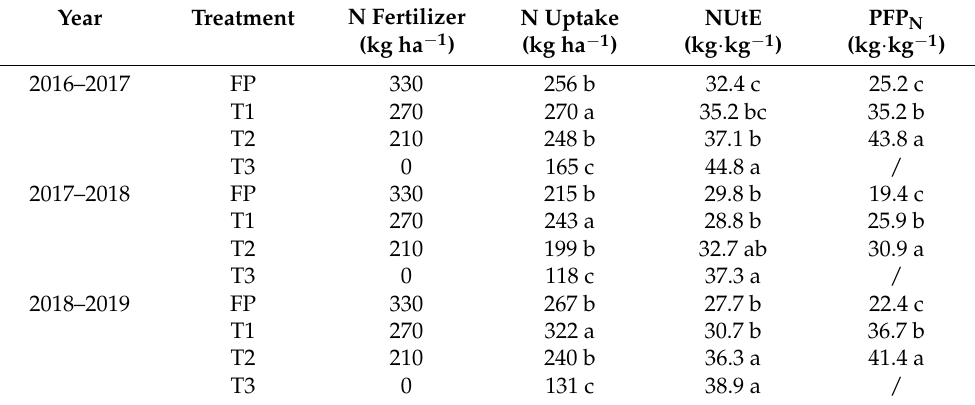
Table 6. Annual chemical N fertilizer input, total N uptake by the plant, N use efficiency (NUtE), and partial factor productivity from applied N (PFPN) under different treatments during 2016–2019 growing